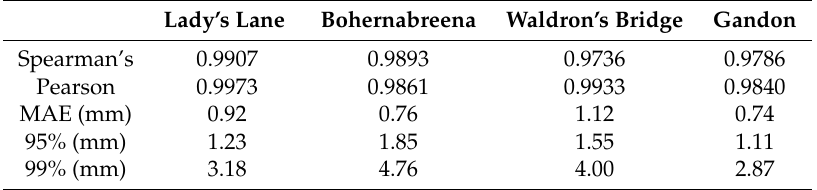
Table 3. Comparison results between Dublin City Council stations and the deployed sensor units using Pearson and Spearman’s rank correlation. The mean absolute error and both of the 95% and 99% confidence intervals of the measurement differences are also shown (all in millimeter).